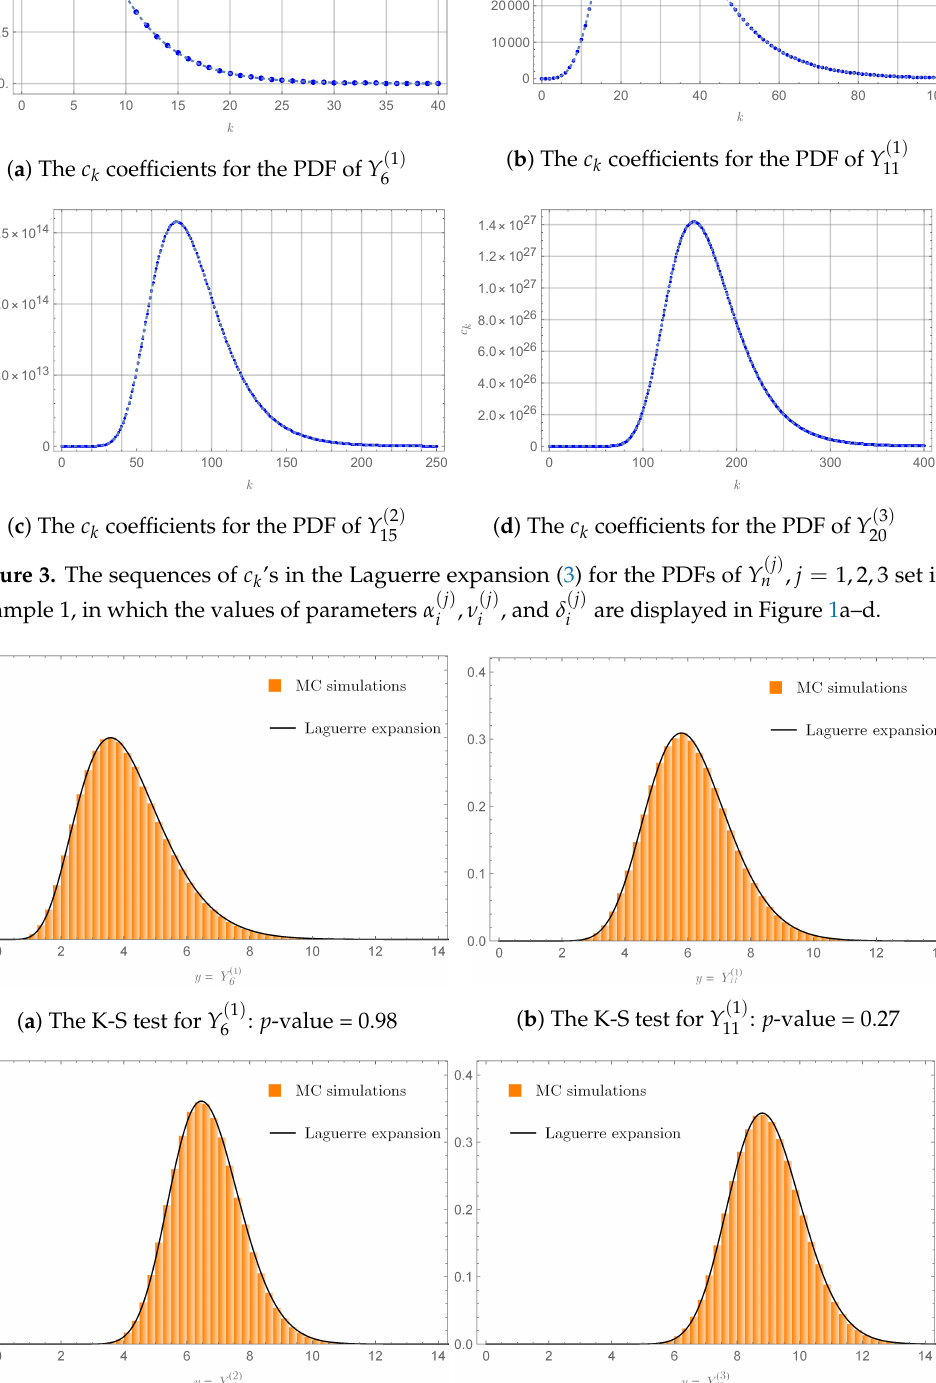
( j ) Figure 4. The PDFs of the Y n ’s in Example 1 computed by using the Laguerre expansion (3), against the corresponding histograms obtained from MC simulations, in which the p -values based on the K-S tests are greater than 0.1 (the significant